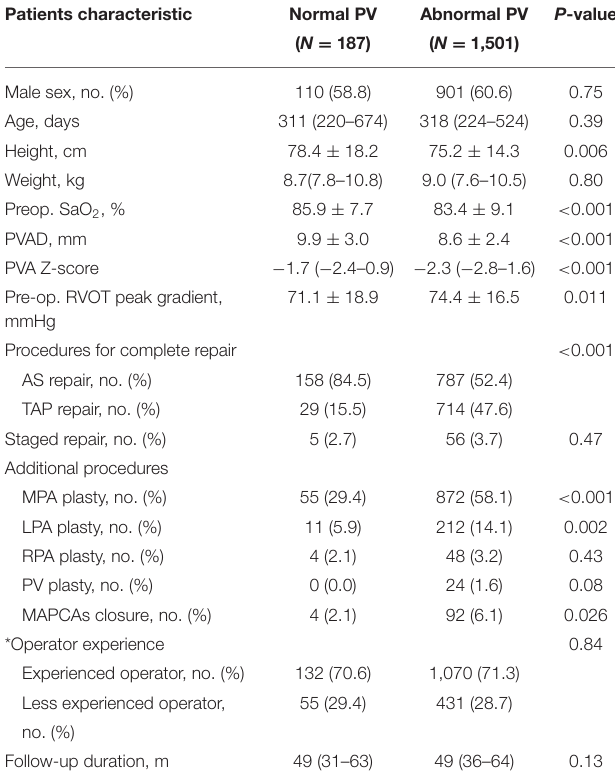
TABLE 1 | Baseline characteristics of patients with